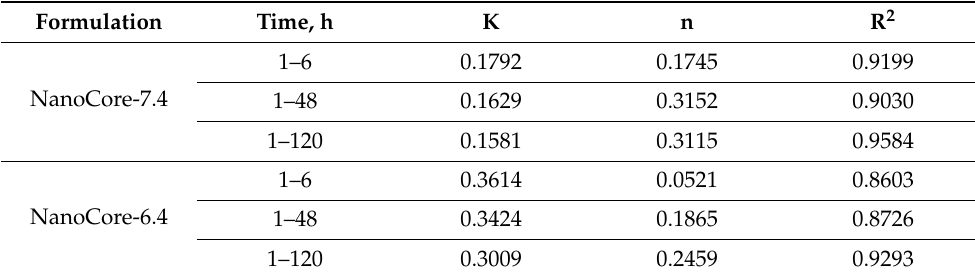
Table 3. Mathematical description and comparison of the 48 h release profiles of doxorubicin from